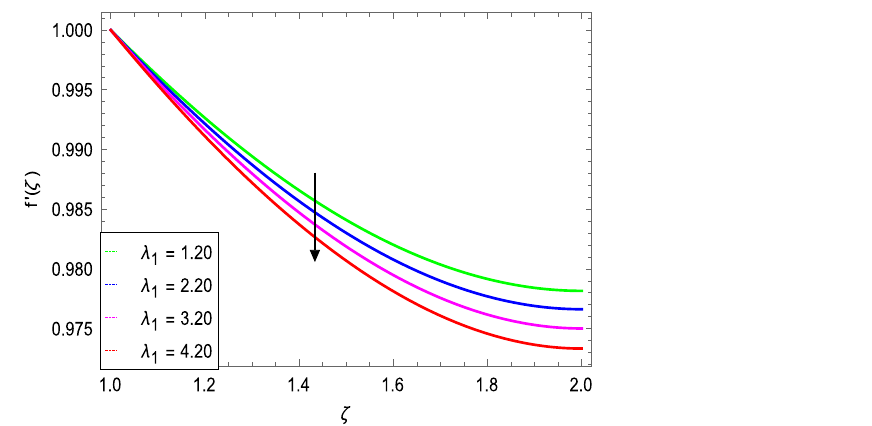
Figure 4. f ′ (ζ) as a function of λ 1 .